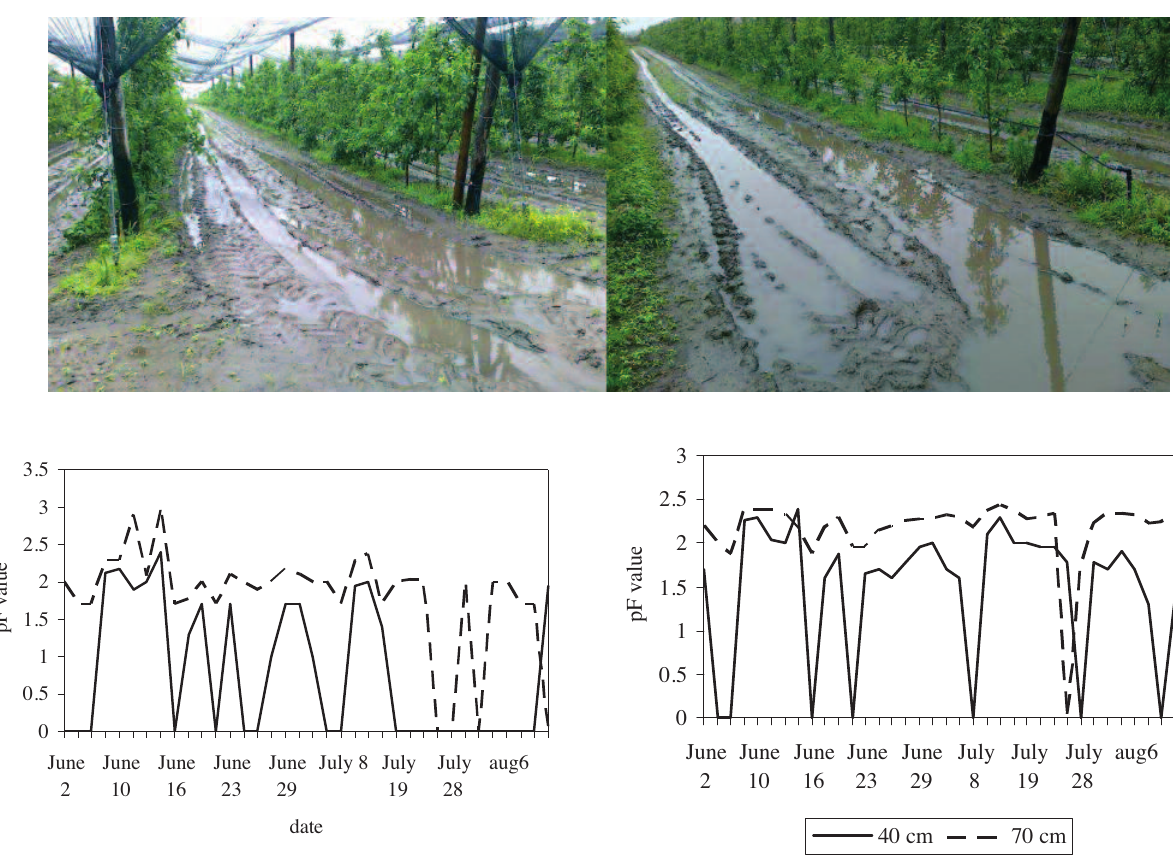
Figure 4: The pF changes in two sampling points